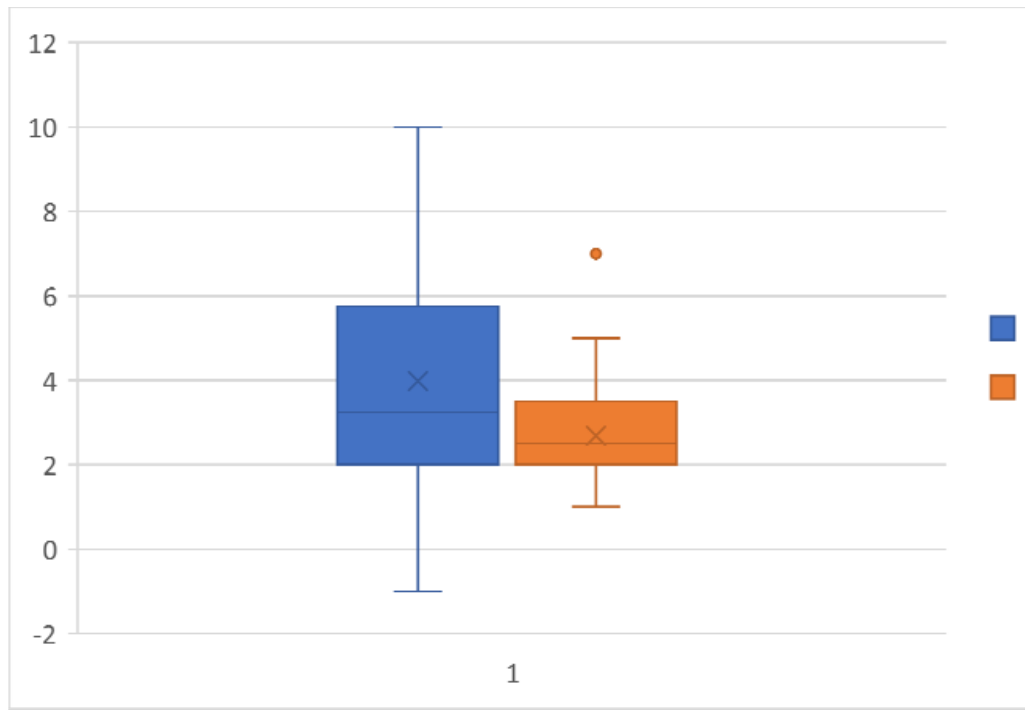
Figure 5. Overjet comparison in the study group and the control group.